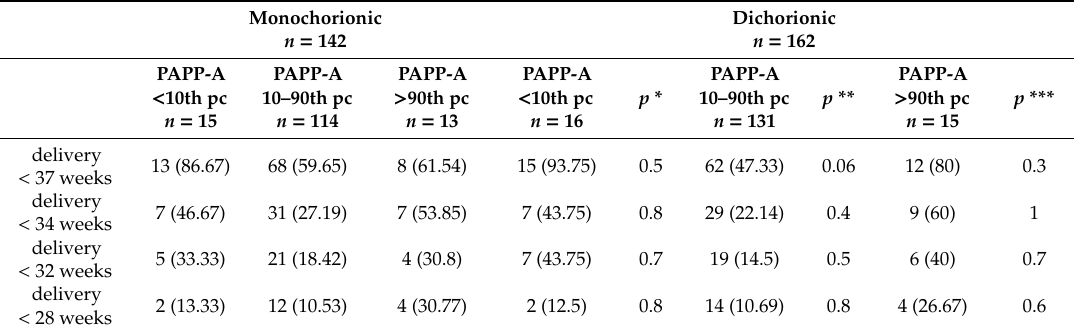
Table 3. Relationships between preterm delivery and PAPP-A concentrations in monochorionic and dichorionic twins.